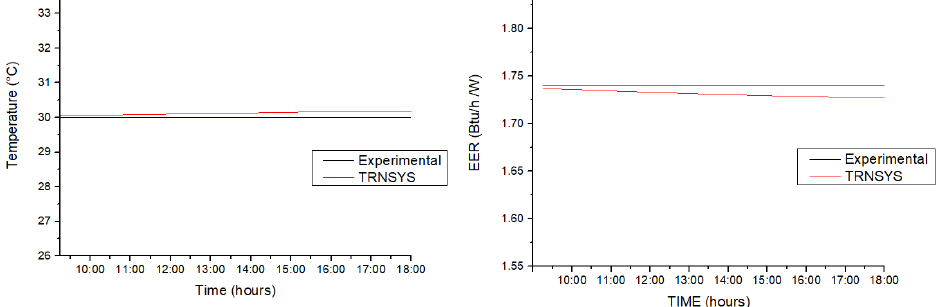
Figure 10. Comparison between simulated and experimental results of temperature and EER at a flow rate of 1GPM.